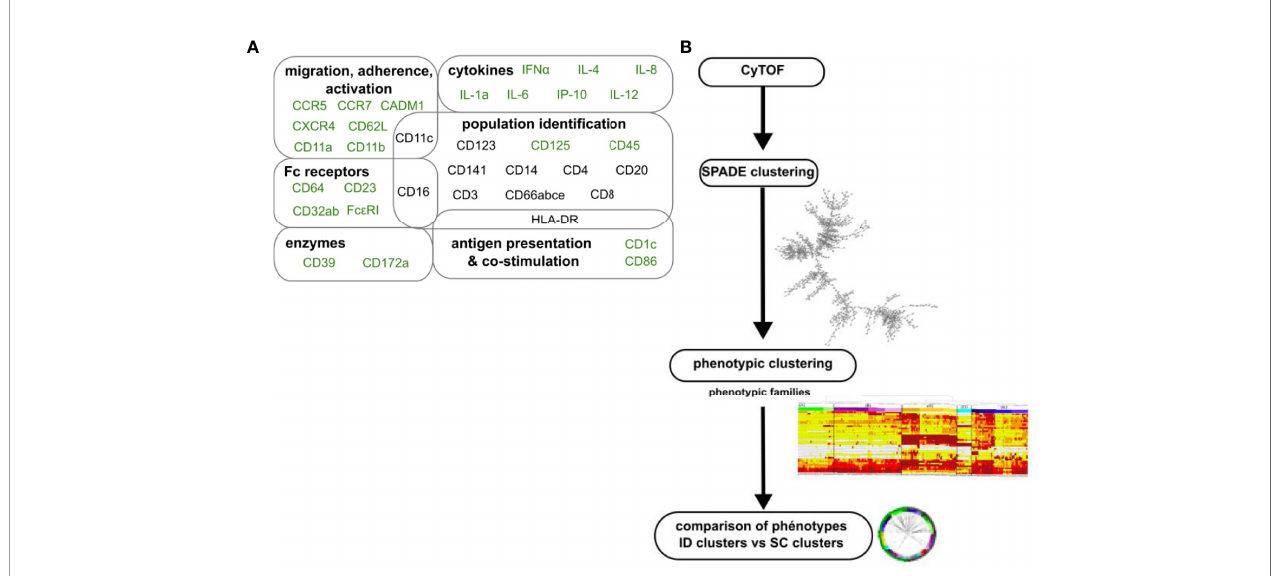
FIGURE 4 | Analytical approach for mass cytometry characterization of granulocytes. (A) Panel of antibodies for mass cytometry analysis. Fixed leukocytes were stained with a panel of metal-conjugated antibodies ( Supplementary Table S1 ). Markers in black were used to compare the phenotype of clusters between datasets. Markers in light grey were excluded from the analysis, not selected as SPADE clustering markers for the ID dataset, or not shared with the SC dataset. (B) Analysis pipeline of mass cytometry data. After ID immunizations, cells sharing a similar phenotype were clustered using the SPADE algorithm. Clusters were manually annotated on the SPADE tree, and granulocytes clusters identi fi ed ( Supplementary Figure S2 ), and further grouped into “ phenotypic families ” and “ superfamilies ” after categorization of their marker expression and hierarchical clustering. Finally, a comparison of marker expression categories based on the Manhattan distance was used to associate granulocytes from the two datasets analyzed separately that display a similar